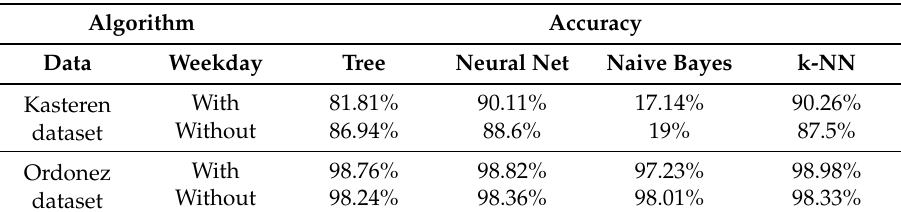
Table 6. Results of accuracy, with or without weekday parameter.